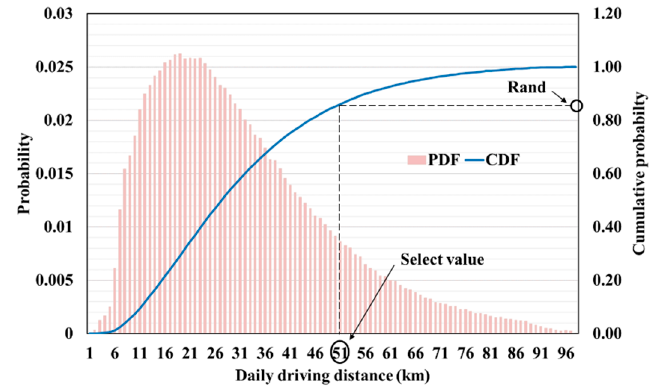
Figure 4. Stochastic method to model the daily driving distance of a PEV.